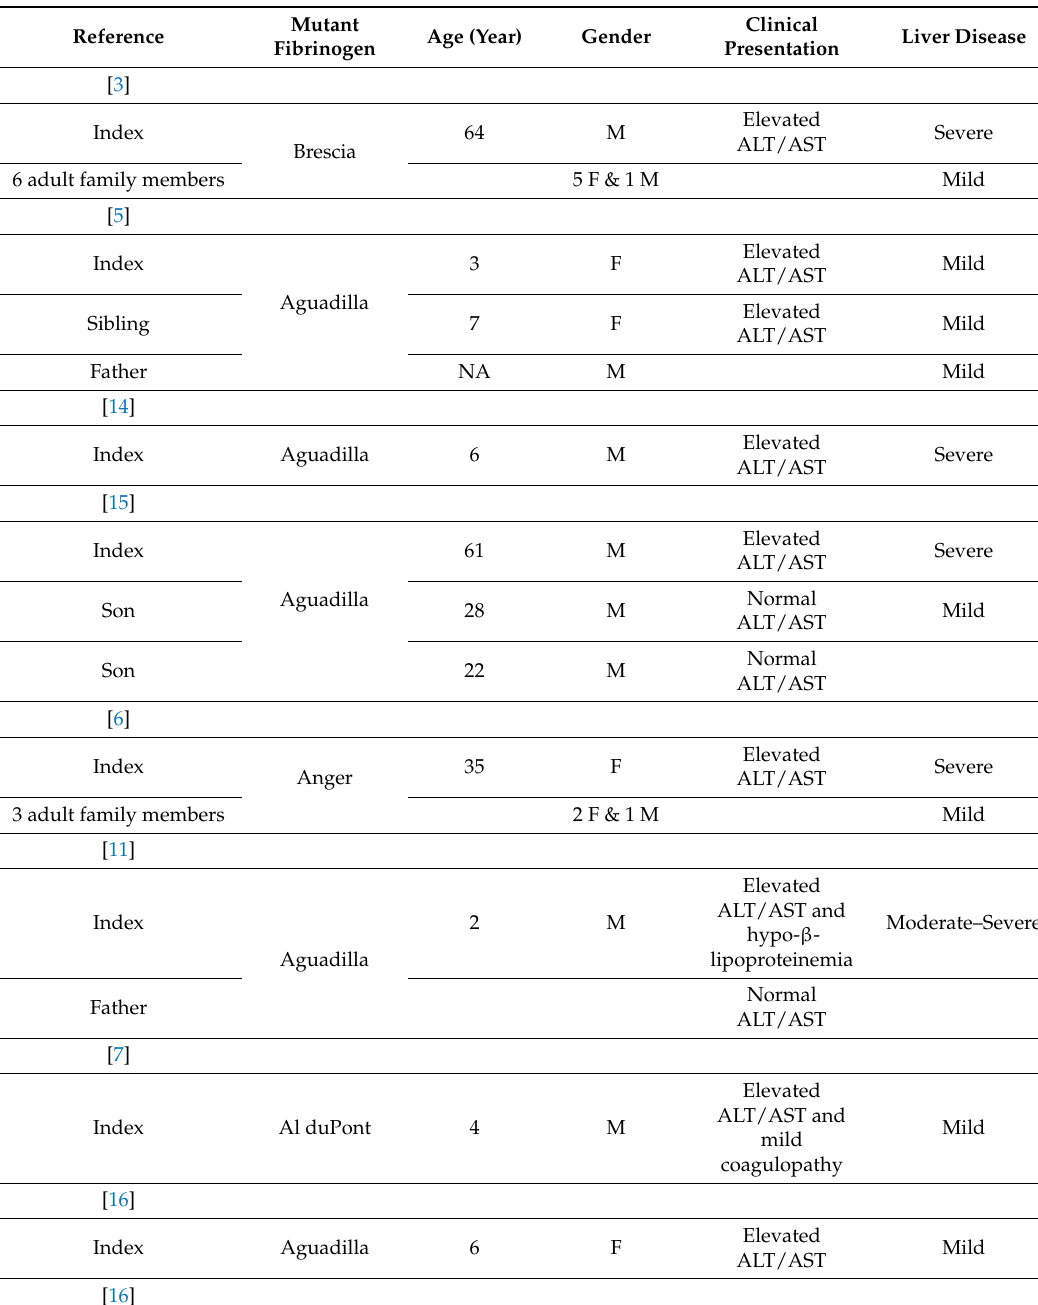
Table 2. Literature review for confirmed cases of FGG